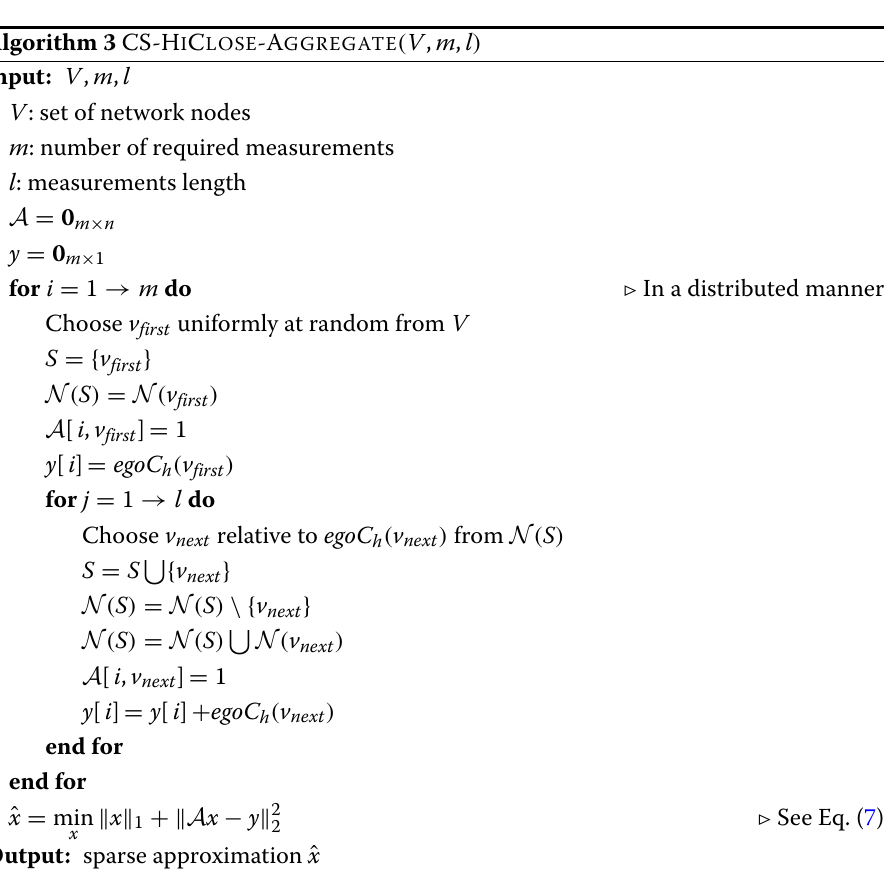
Algorithm 3 CS-H I C LOSE -A GGREGATE ( V , m , l